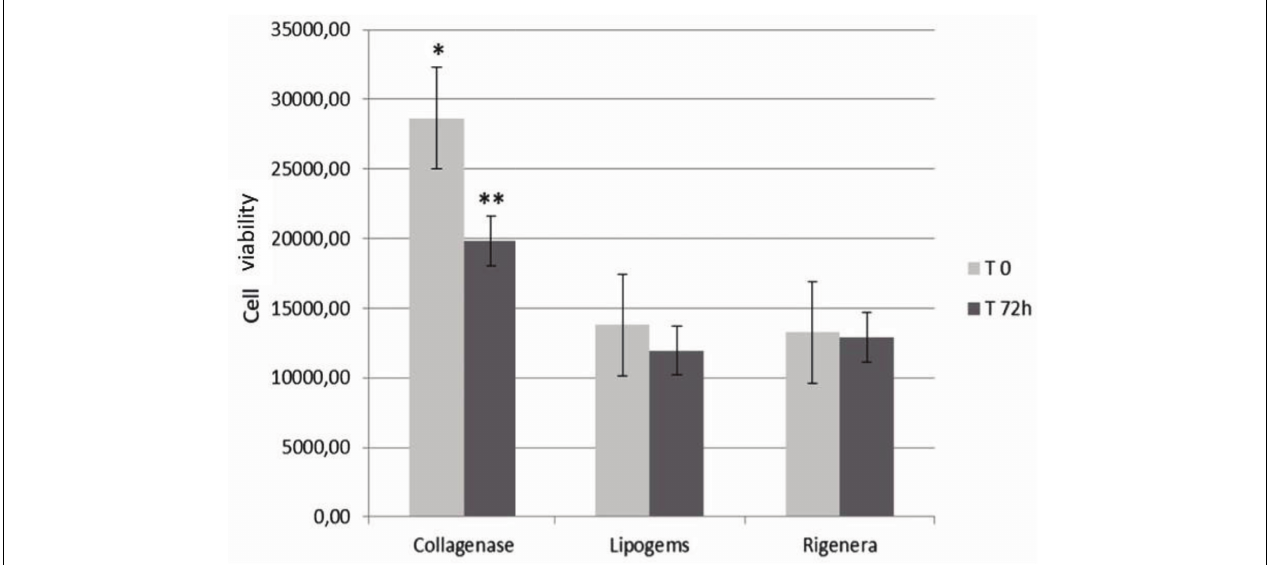
FIGURE 1 | Cell viability values (average of the samples) at T0 and T72h. Data marked with ∗ are statistically significant. Cell viability of SVF obtained by collagenase was significantly higher than those of mechanical methods ( ∗ ). However, the enzymatic procedure has been the only methods characterized by a significant decrease in cell viability at T72h ∗∗ . Cell medium was changed twice weekly in DMEM supplemented with 10% Foetal Bovine Serum (FBS) and 1% penicillin-streptomycin (all Gibco R (cid:13) , Thermo Fisher Scientific, Paisley, United Kingdom), seeded in 96-well plates (100 µ l/well) and were stored in a humidified incubator at 37 ◦ C with 5% CO 2 to assess